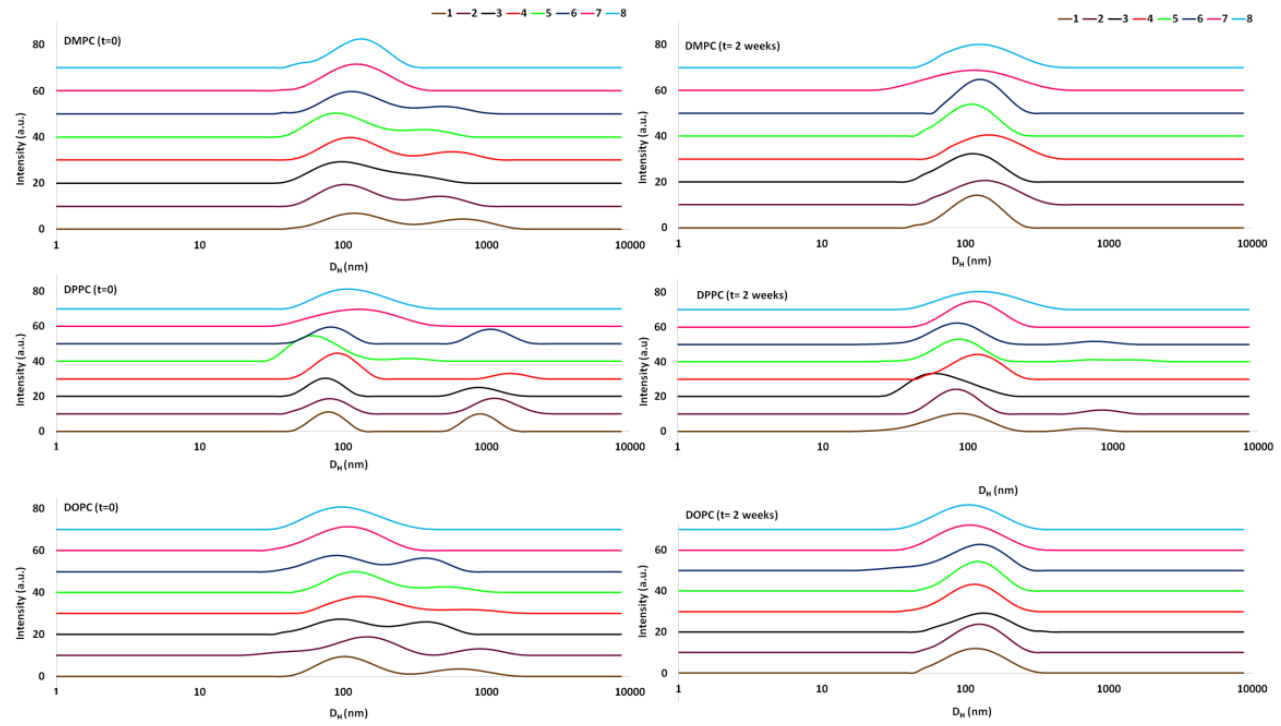
Figure 6. Intensity weighted distributions of the hydrodynamic diameter (D H ) obtained by DLS on the quinoline loaded liposomes just after the preparation (t = 0) and after two weeks (t = 2 weeks).